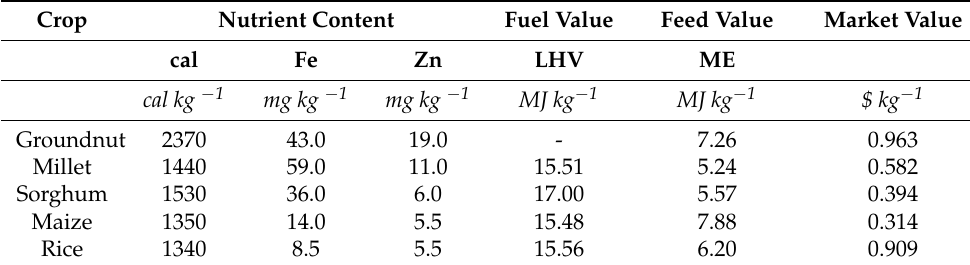
Table 1. Nutrient content, fuel, feed and market value of cropland